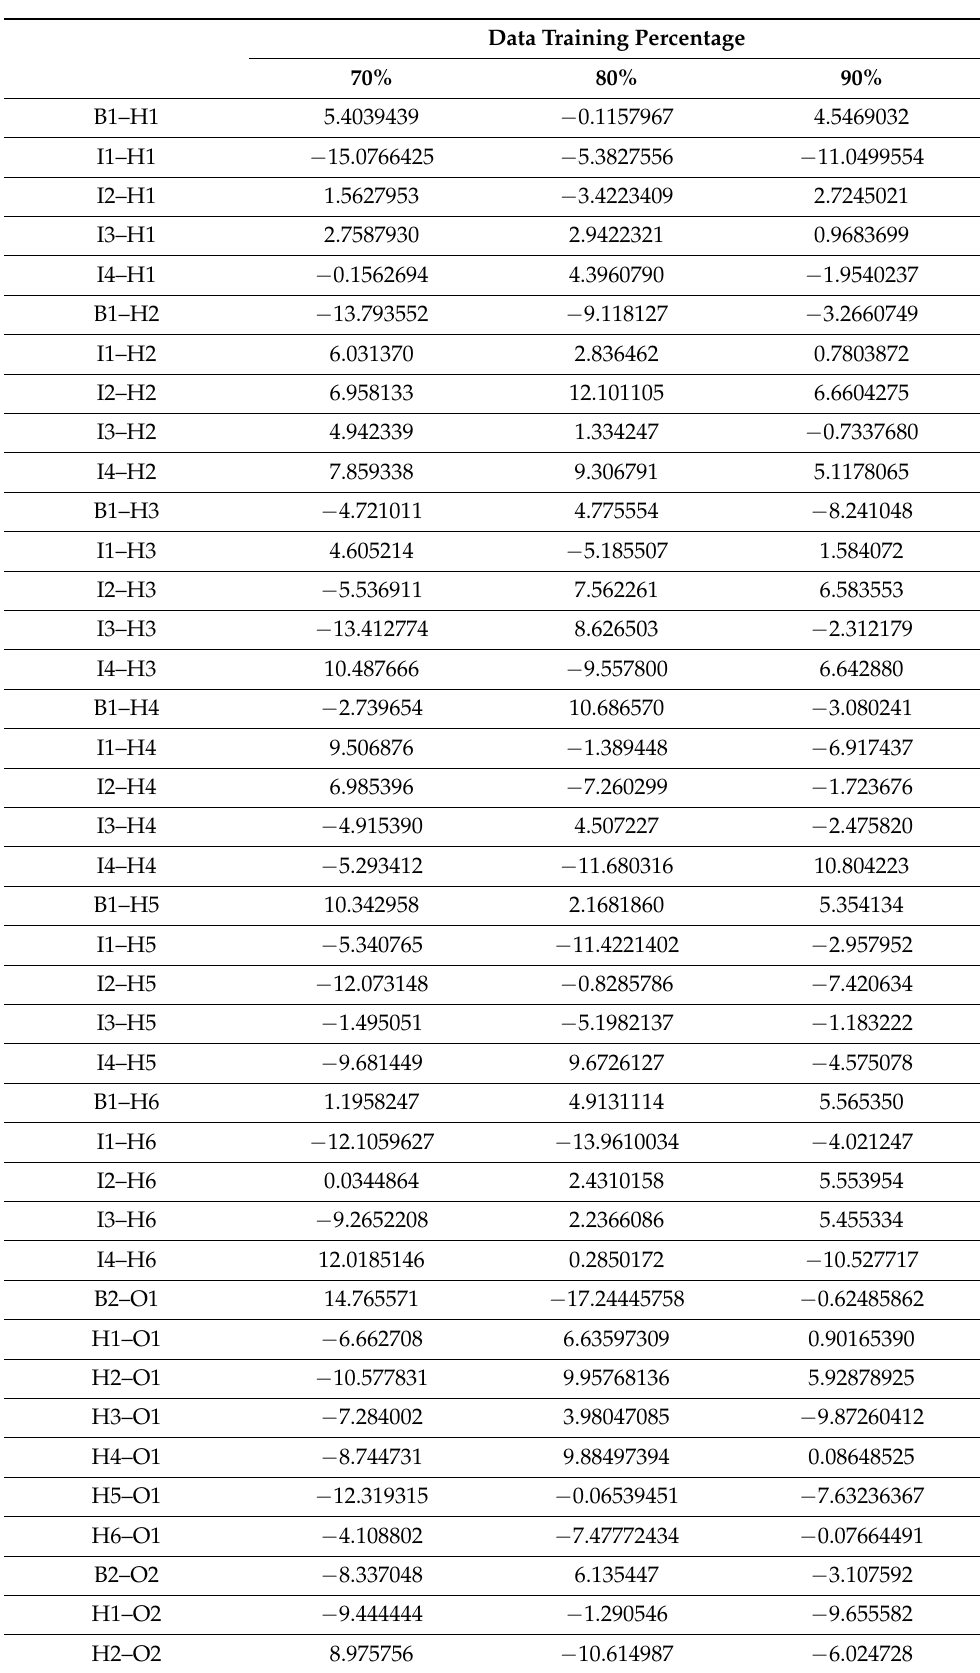
Table 6. The biases and weights of the ANN model developed using tanh activation